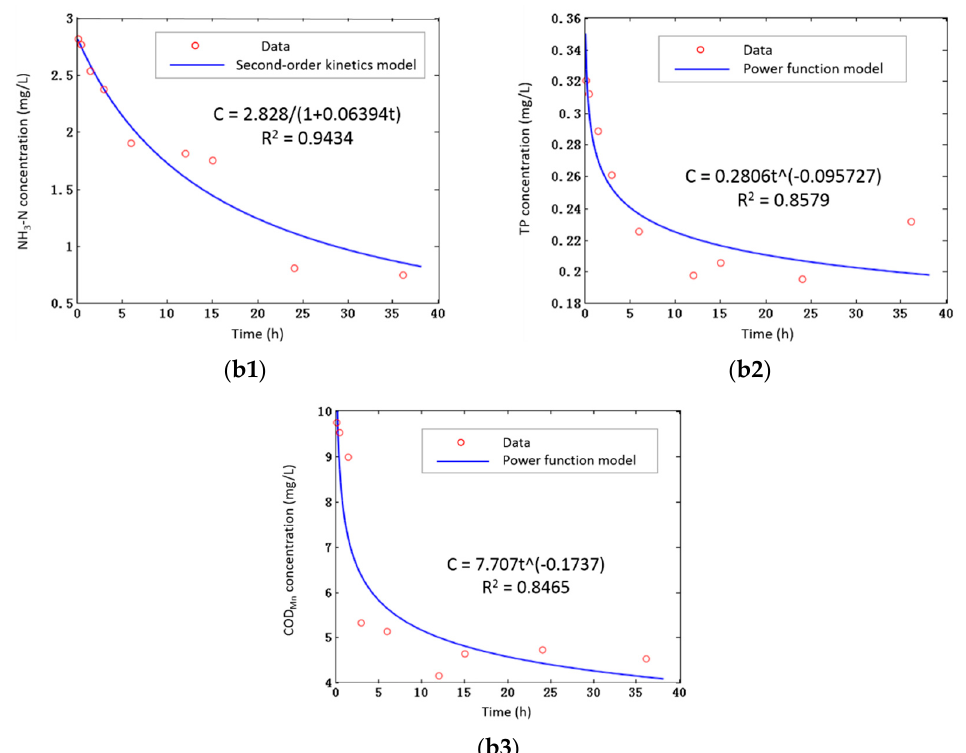
Figure 6. The optimal fitting results of adsorption and biodegradation kinetic model for ( a1 , b1 ) NH 3 -N, ( a2 , b2 ) TP and ( a3 , b3 ) COD Mn .